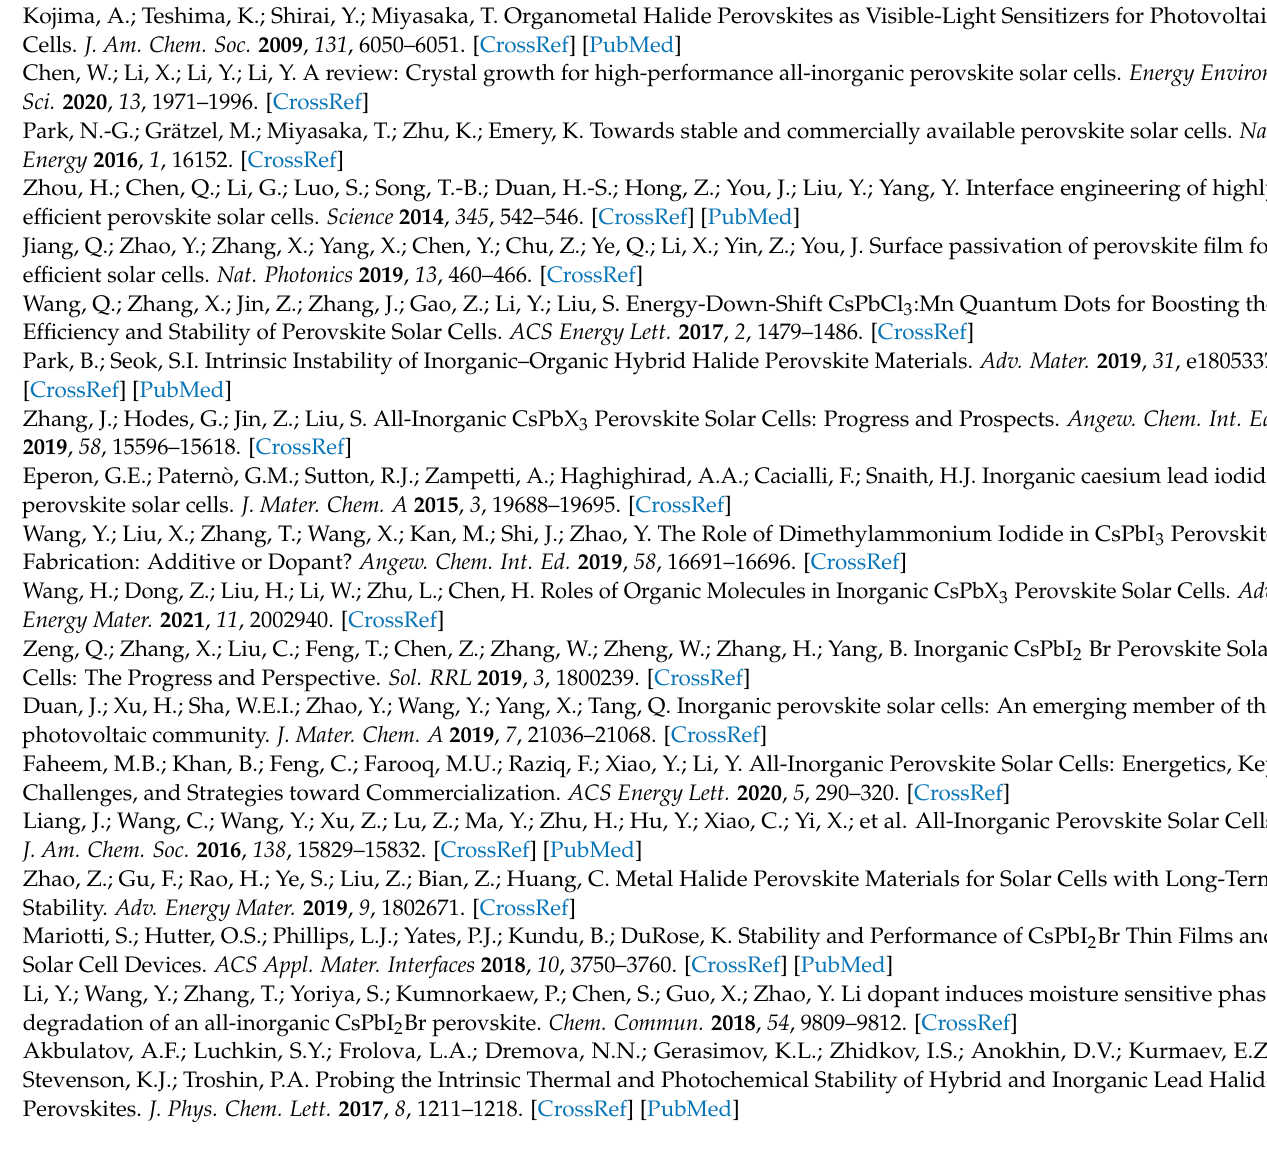
M; Figure S2: The SEM image of InBr 3 :PbBr 2 film (a) and the corresponding EDS mapping of Pb (b), Br (c) and In (d); Figure S3: XPS spectra of InBr 3 :CsPbBr 3 film; Figure S4: The cross-sectional SEM image of InBr 3 :CsPbBr 3 film (a) and the corresponding EDS mapping of Cs (b), Pb (c), Br (d) and In (e); Figure S5: UV-vis absorption spectra (a) and ( α h ν ) 2 vs. h ν plots (b) of the modules by introducing different concentrations of InBr 3 ; Figure S6: J – V curves with forward and reverse voltage scanning for the InBr 3 :CsPbBr 3 devices: (a) 0.00 M; (b) 0.03 M; (c) 0.09 M; (d) 0.15 M; (e) 0.21 M; (f) 0.27 M; Table S1: Electrochemical Impedance Spectroscopy parameters of the pristine and InBr 3 (0.21 M):CsPbBr 3